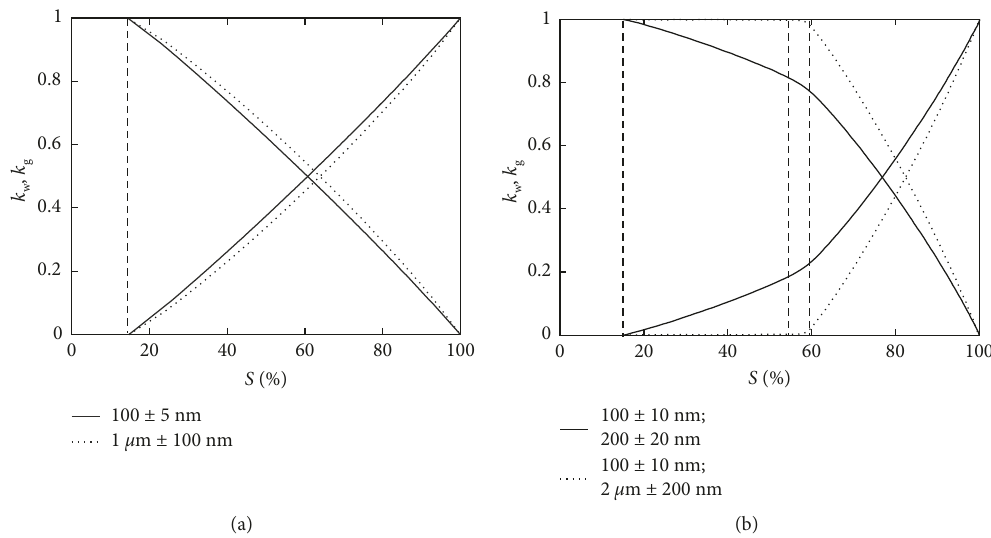
Figure 3: Relative permeabilities for four cases of mono- and bimodal distributions.